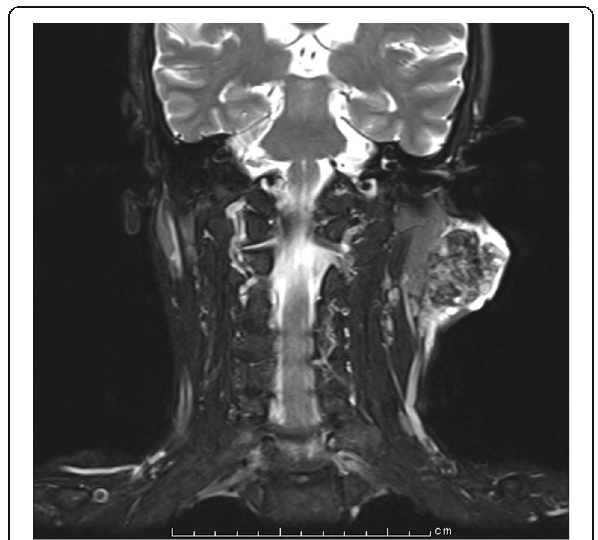
Fig. 2 T1-weighted magnetic resonance imaging (MRI) of the left parotid region. A well-defined multilocular tumor with heterogeneous enhancement was seen. The tumor was located close to the outside of the left parotid gland